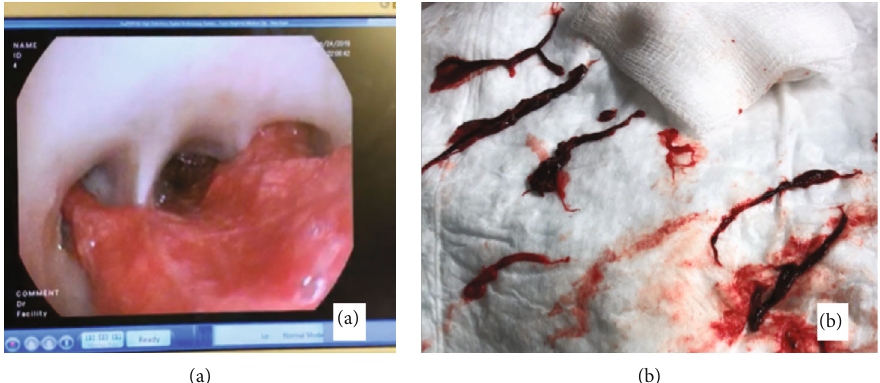
Figure 3: (a) Bronchial airway obstruction from blood clots. (b) Manually retrieved blood clots from large airway via forceps extraction.